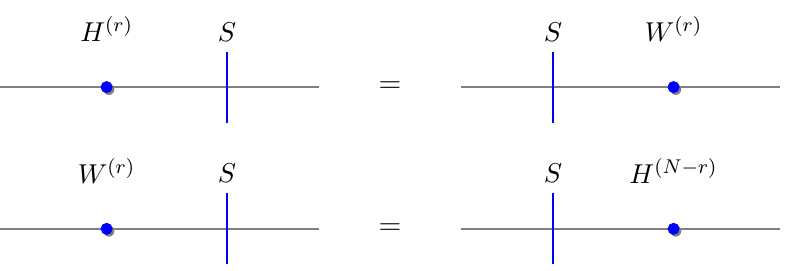
Figure 6 . Under S duality, a Wilson loop becomes an ’t Hooft